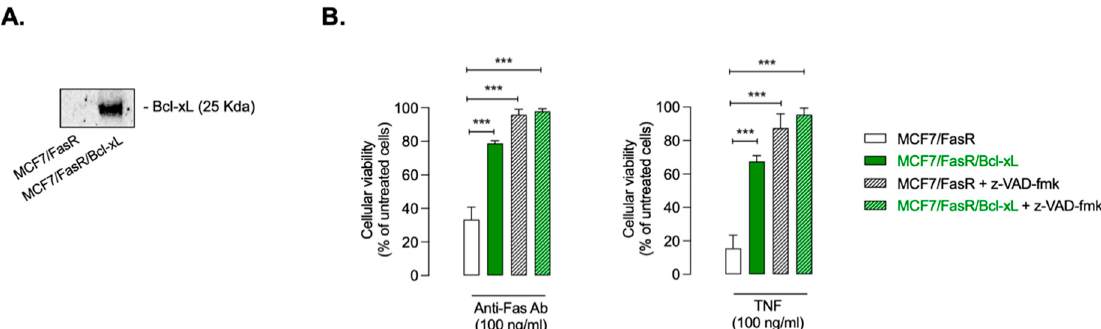
Figure 11. Bcl-xL and z-VAD-fmk inhibited by Fas- or TNF α -induced cell death in MCF7 cells. ( A ) Cellular proteins from MCF7/FasR and MCF7/FasR/Bcl-xL cells were separated by SDS-PAGE and immunoblotted using anti-Bcl-xL antibody. ( B ) MCF7/FasR and MCF7/FasR/Bcl-xL treated with 100 ng/mL anti-Fas or 100 ng/mL TNF α for 72 h in presence or in absence of 10 μ M pan-caspase inhibitor z-VAD-fmk. Cell death was assessed by MTT assay. Results are means ± SD of 3 independent experiments (***, p < 0.0001).